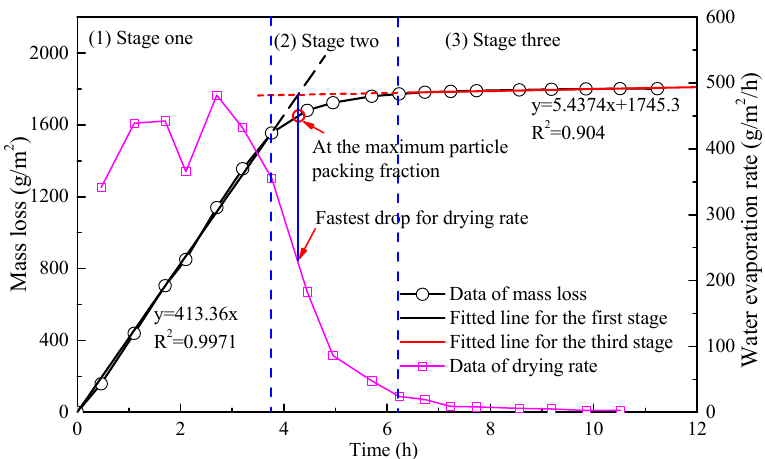
Figure 4. Drying process of bitumen emulsion (LF-1). Figure 4. Schematic representation of the three-stage drying process.